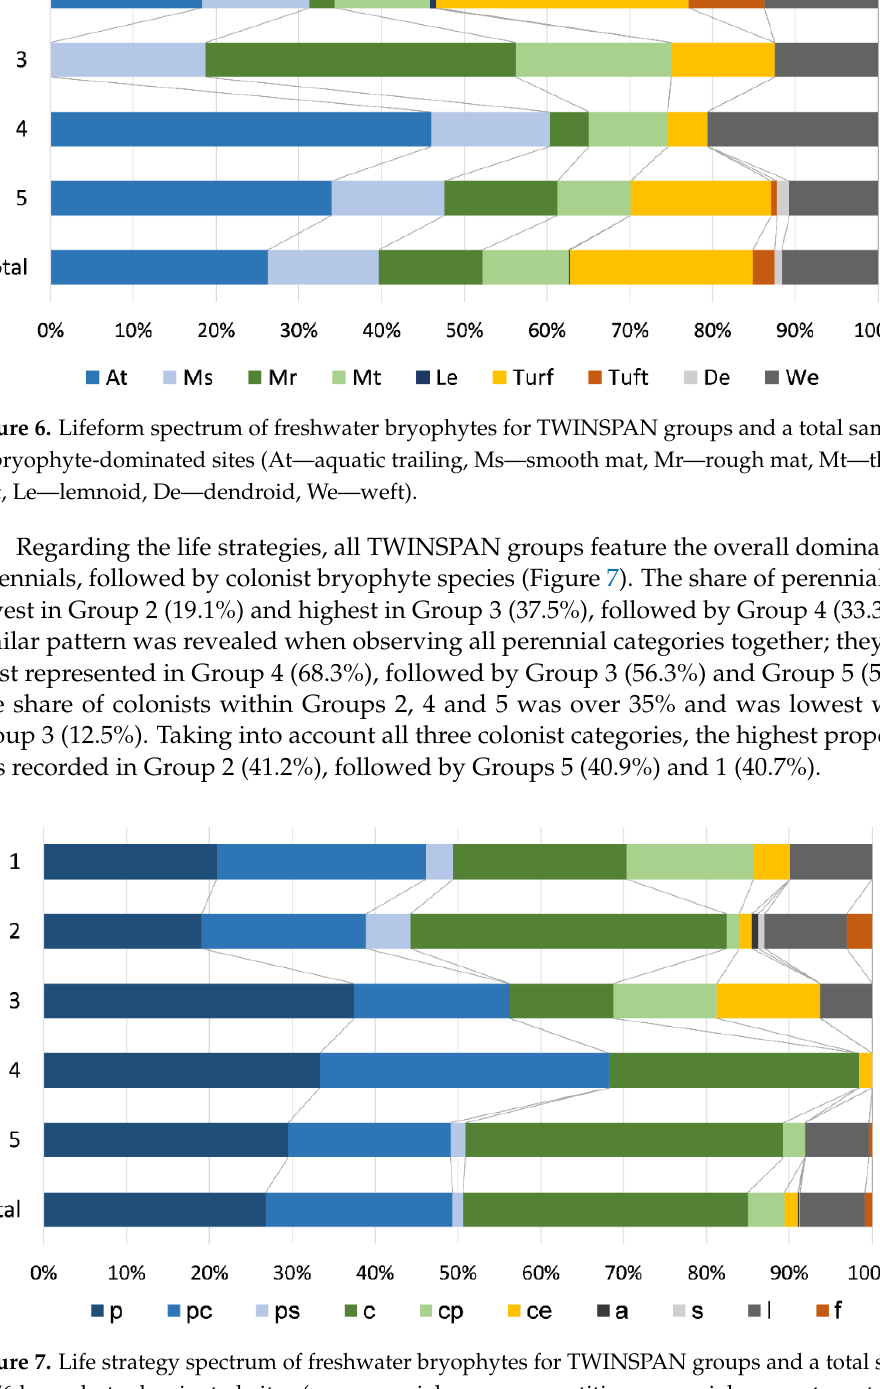
Figure 7. Life strategy spectrum of freshwater bryophytes for TWINSPAN groups and a total sam- ple of 76 bryophyte dominated sites (p—perennials, pc—competitive perennials, ps—stress-tolerant perennials, c—colonist, cp—pioneer colonist, ce—ephemeral colonist, a—annual shuttle, s—short- lived shuttle, l—long-lived shuttle, f—fugitives).